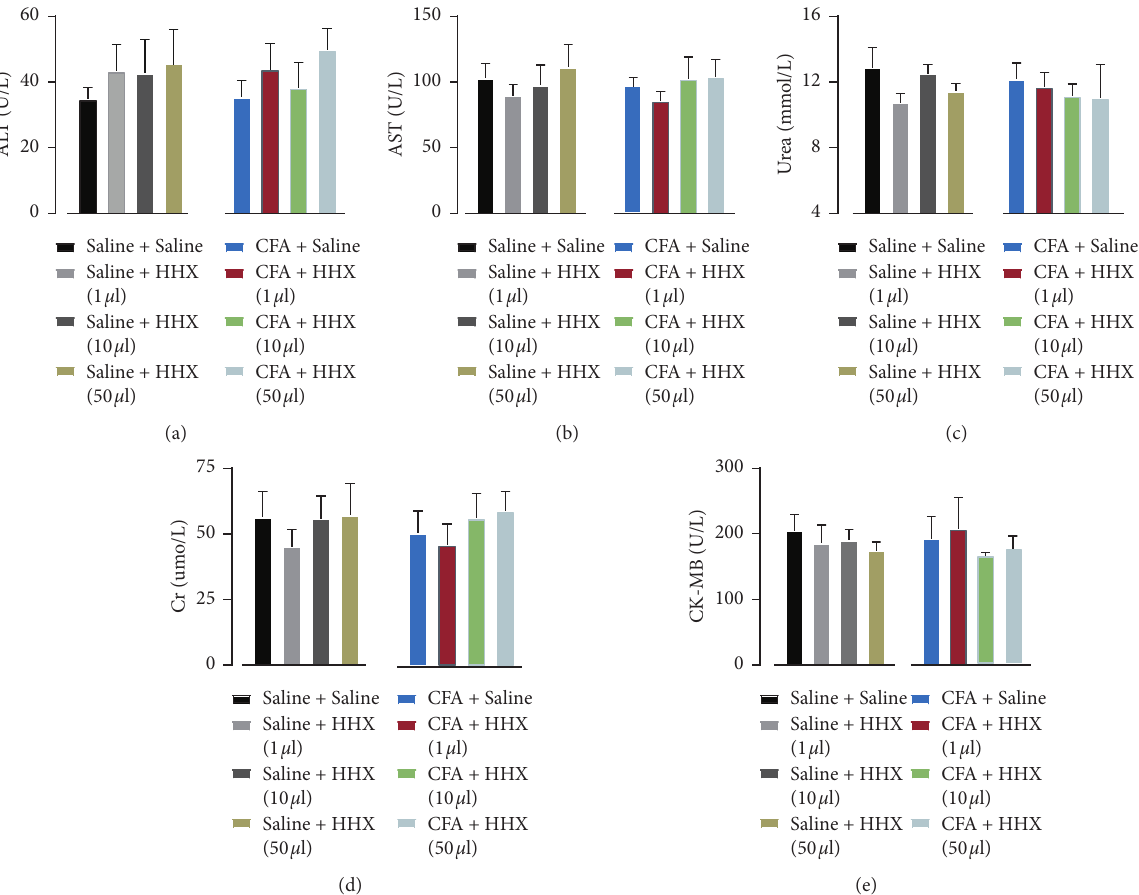
Figure 6: The effect of HHX on blood biochemical index. There were no significant differences of serum levels of ALT (treatment between columns, F (7, 39) � 0.3886, P � 0 . 9033), AST (treatment between columns, F (7, 39) � 0.3444, P � 0 . 9282), Cr (treatment between columns, F (7, � 0.3247, P � 0 . 9382), urea (treatment between columns, F 39) � 0.3788, P � 0 . 9091) across the different groups at day 39)